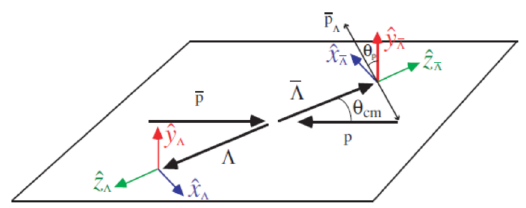
Figure 5. The reference system of the ¯ pp → ¯ YY